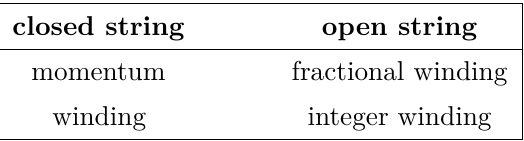
Table 1. The mapping between quantum numbers of closed and open strings in the KLT